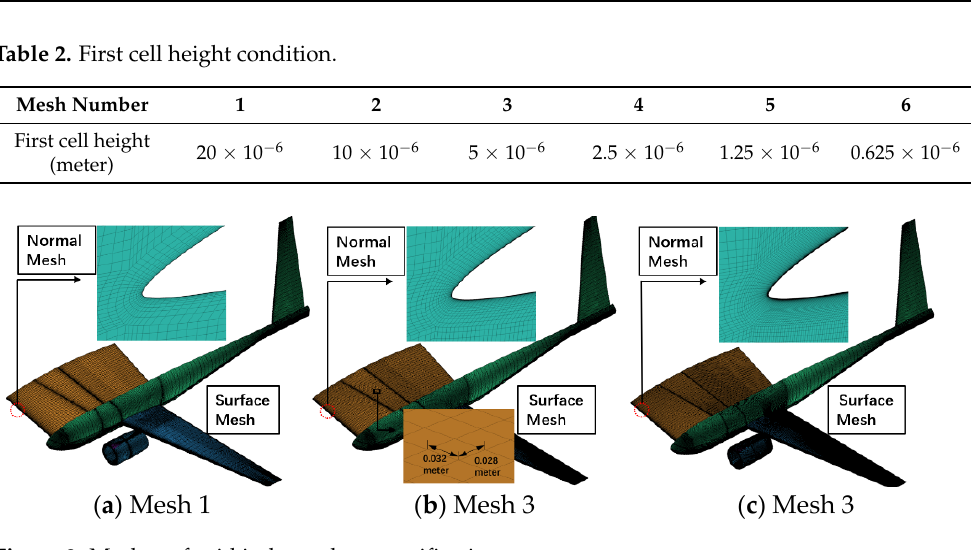
Figure 3. Meshes of grid independence verification.